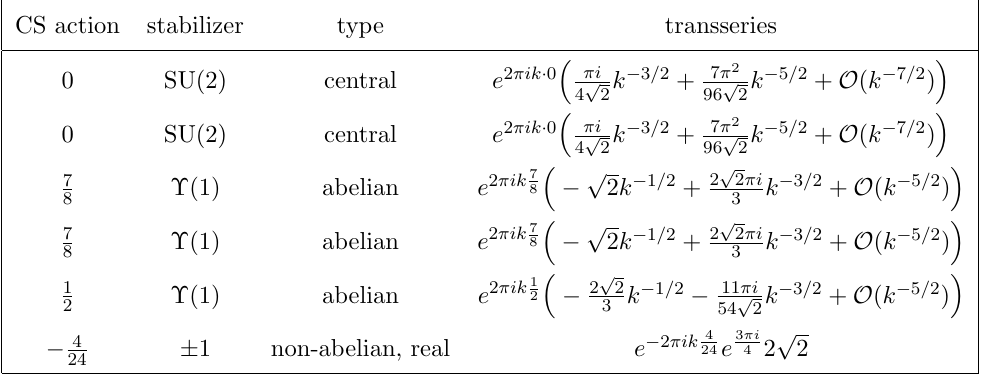
2; 1 ; 1 ; 1 2 3 2 (cid:0)